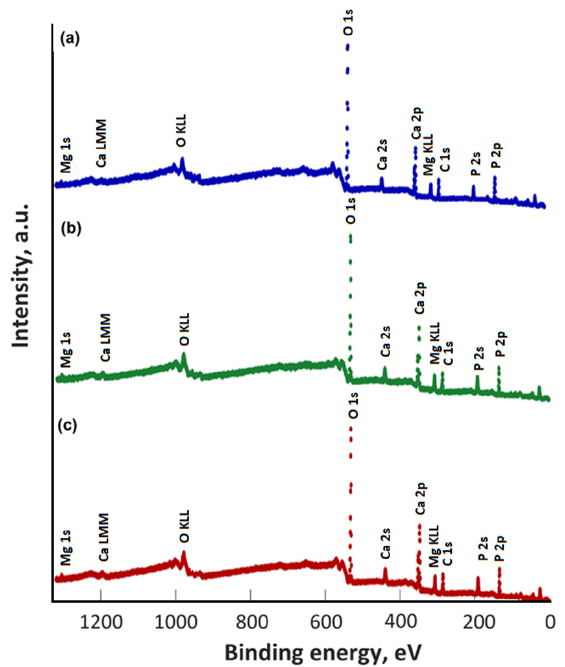
Figure 10. XPS survey results of 10 MgHApCh-0 ( a ), 10 MgHApCh-3 ( b ), and 10 MgHApCh-6 ( c ).